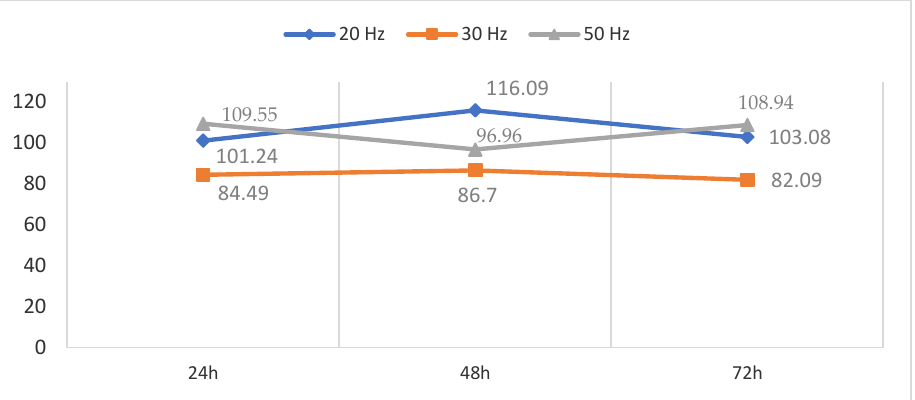
Figure 3. ( a ) The EUT chamber where the cells were placed; ( b ) NIH/3T3 mouse fibroblast cell line cells inside the EUT chamber.